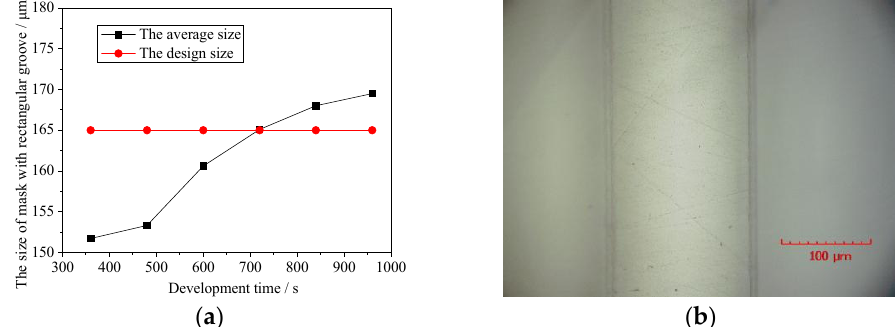
Figure 6. Development results: ( a ) average mask size relative to design size with different develop- ment times; ( b ) local morphology of mask with development time of 720 s.